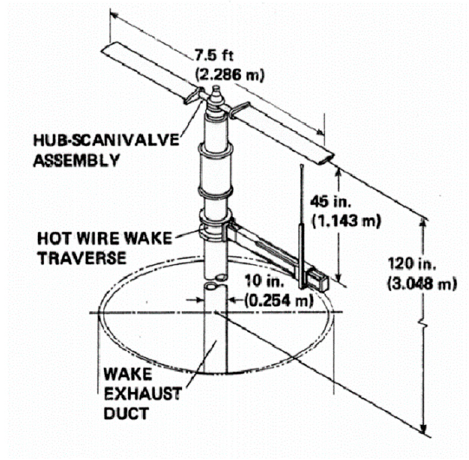
Figure 1. Sketch of Caradonna–Tung rotor experimental device.